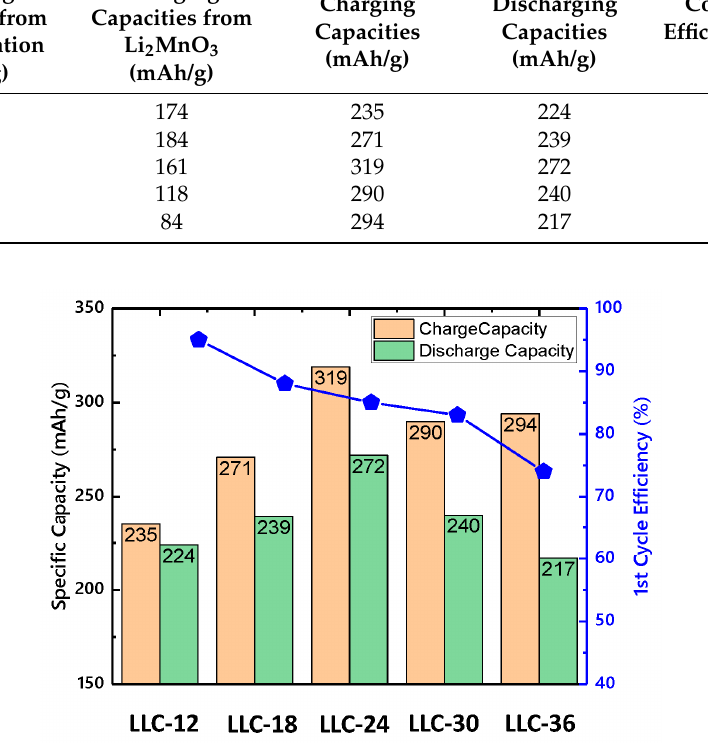
Figure 3. ( a ) First − cycle specific charge capacity vs. voltage curve. ( b ) Differential capacity (dQ/dV) plots for 1st cycle charging. ( c ) First–cycle specific discharge capacity vs. voltage curve and ( d ) dif- ferential capacity (dQ/dV) plots for 1st cycle discharge for all the LLC electrodes. Cells were cycled between 2.0 and 4.7 V at a C/20 rate. Table 3 summarizes the first-cycle specific capacity and Coulombic efficiency for all the samples. The contributions of Ni 2+ oxidation and Li 2 MnO 3 activation to the capacity are calculated based on the voltage profile. The capacity from Ni 2+ oxidation increases while that from Li 2 MnO 3 activation decreases with Ni content. By combining these two factors, the LLC − 24 sample shows the highest capacity. However, the first cycle Cou- lombic efficiency decreases as the Ni content increases, which attribute to the increase in cation mixing. The Coulombic efficiencies of LLC − 12 and LLC − 18 samples are higher than LLC − 24, LLC − 30 and LLC − 36 because better Li-ion diffusion pathway formed from spinel structure (See Figure 4). Table 3. Specific charge and discharge capacities and Coulombic efficiencies of LLCs.